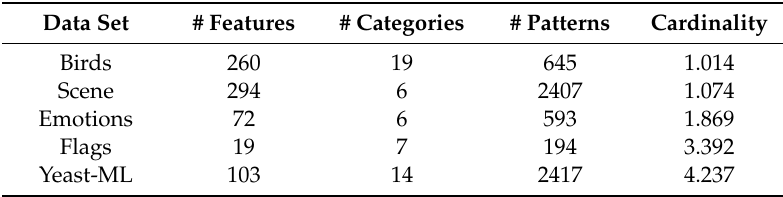
Table 7. Multi-label data sets for